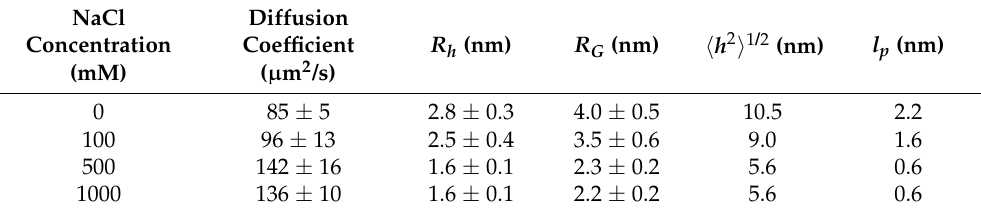
Table 1. Properties of poly(dT 60 ) ssDNA at different NaCl concentrations [29]. The diffusion coeffi- cient measurements were conducted in pH 8 IDTE buffer